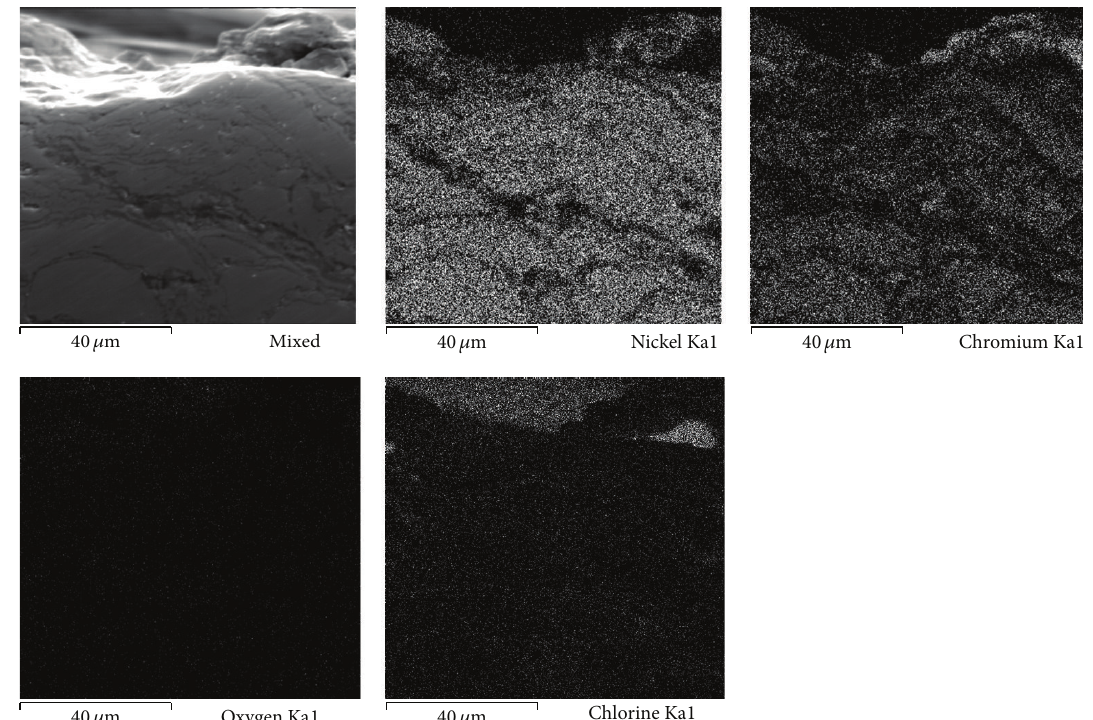
Figure 7: Cross-sectional aspect of the Ni20Cr as-deposited coating and elements distribution after corrosion test at 350 ∘